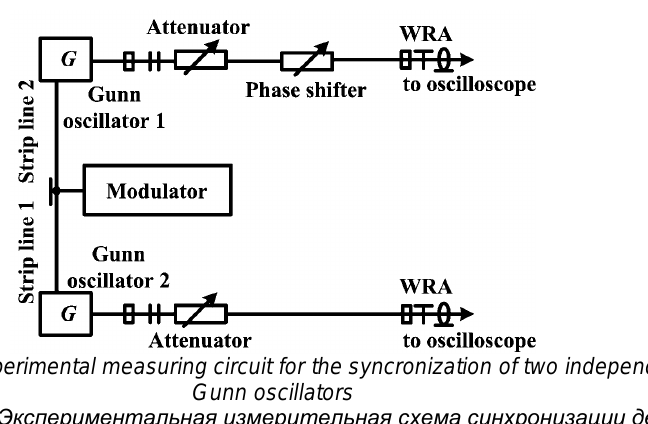
Figure 6 – Experimental measuring circuit for the syncronization of two independent Gunn oscillators